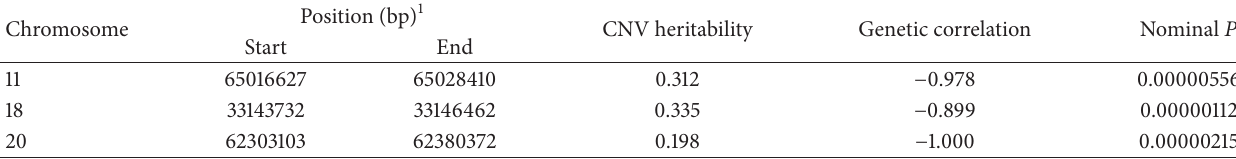
Table 3: CNV regions attaining significant pleiotropy with BMI.